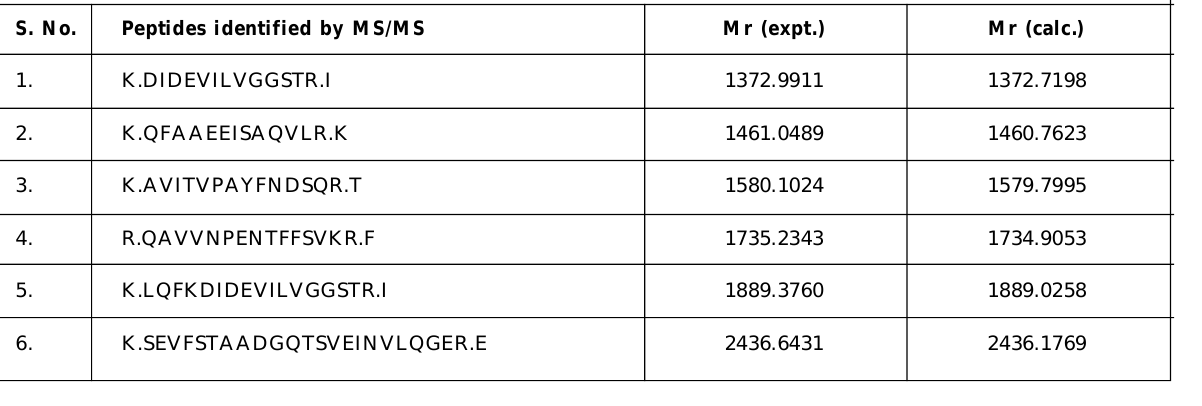
Table 4A: The MALDI TOF mass spectrum sequence of peptides matched with gi|145388994 chloroplast heat shock protein 70 of Cenchrus americanus (Protein score: 295) S. No.